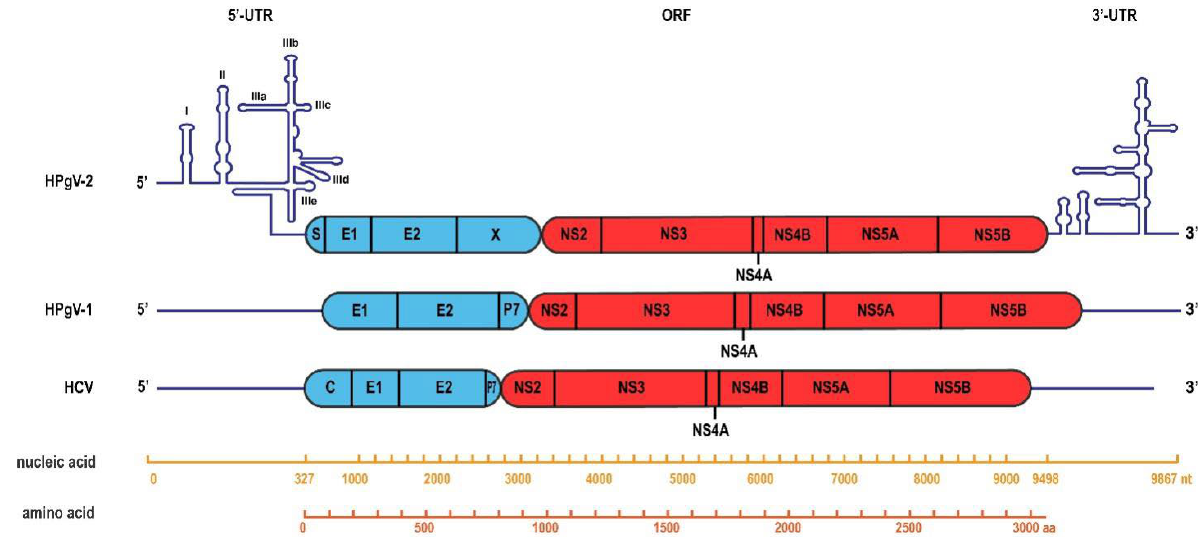
Figure 1. Genome organization of HPgV- 2. The genome consists of the 5′ UTR, 3′ UTR and ORF region, encoding four structural proteins and six non-structural proteins [8,15].